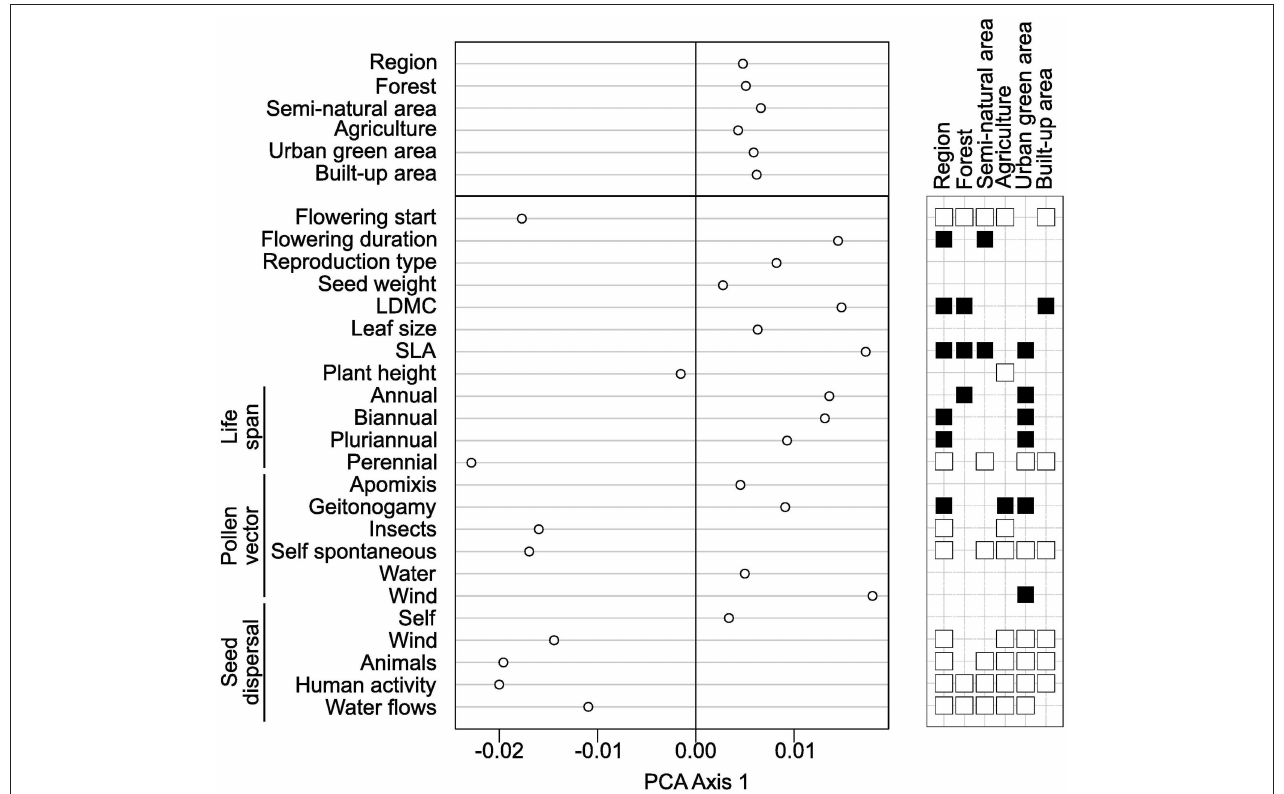
FIGURE 5 | Analysis of the coefficients of the generalized least squares (GLS) models applied to species functional originalities with traits as explanatory variables. As indicated in the main text, we performed one model for the regional originality and one for each of the land cover types. Then, we applied a principal component analysis (PCA) on the table with land cover types as columns, traits as rows and the coefficients of the GLS models as entries ( Table S5 ). The left part of the figure displays a dot plot with the coordinates of land covers and of traits on the first axis of the PCA. Next to the dot plot, a table indicates which traits significantly increased (black squares) or decreased (white squares) with species functional originality. The absence of a square indicates that species functional originality was found independent of the